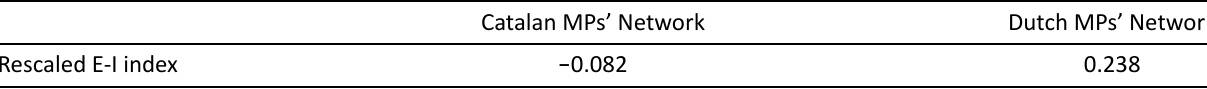
Table 3. Rescaled E‐I index of the Catalan MPs’ Twitter mentions network and the Dutch MPs’ Twitter mentions